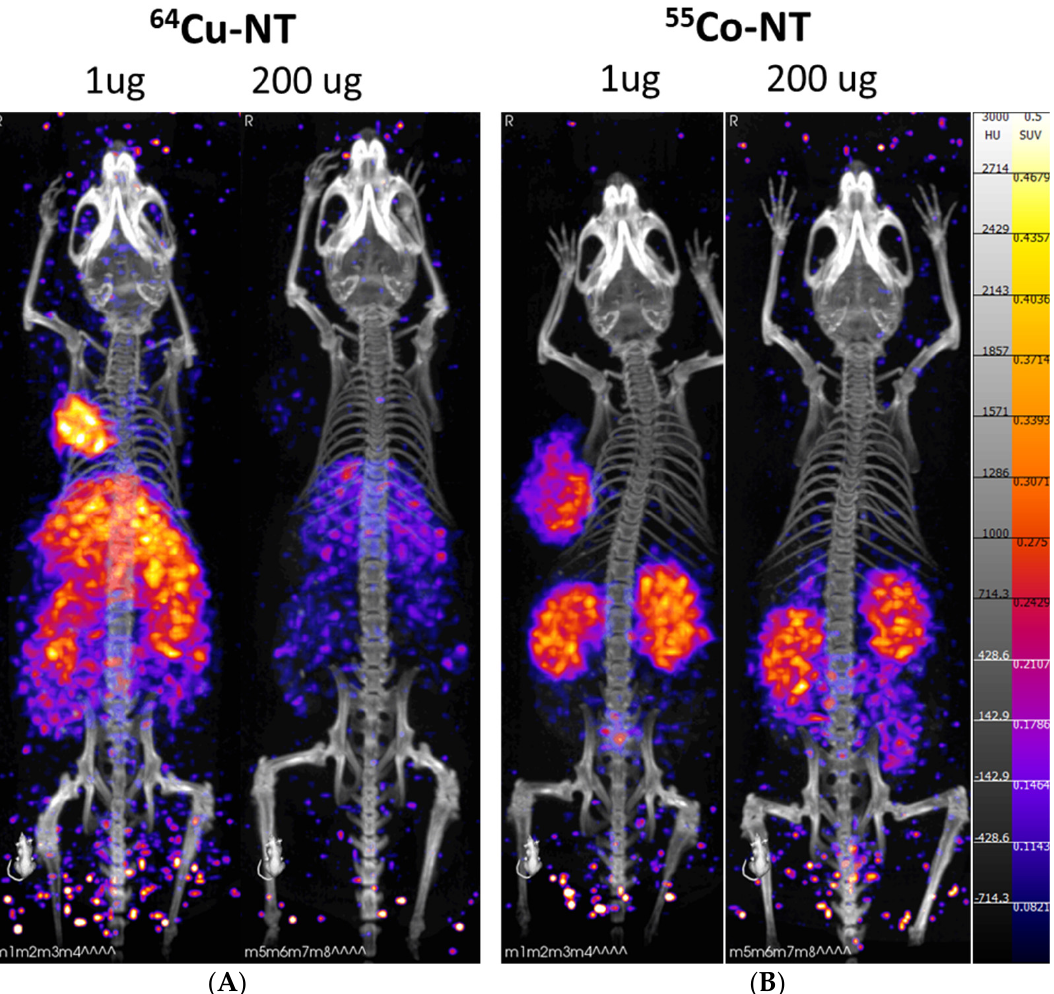
Figure 5. PET/CT imaging 24 h post-injection with radiolabeled NOTA-NT-20.3 in mice bearing HT29 tumor xenografts. Mice were imaged with [ 64 Cu] Cu-NOTA-NT-20.3 ( A ) and [ 55 Co] Co-NOTA-NT-20.3 ( B ).